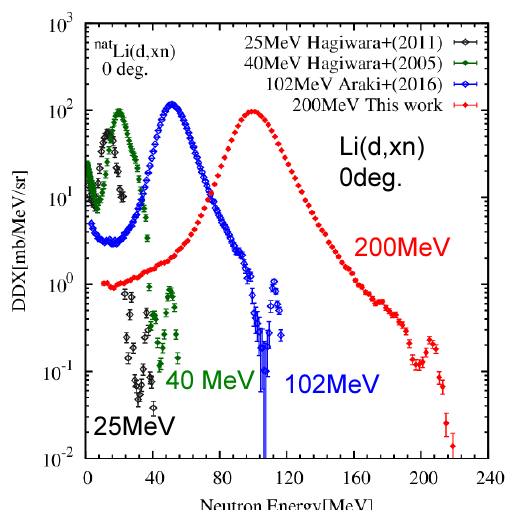
Figure 2. Measured double-di ff erential cross sections (DDXs) of the ( d , xn ) reaction on Li at an incident energy of 200 MeV.